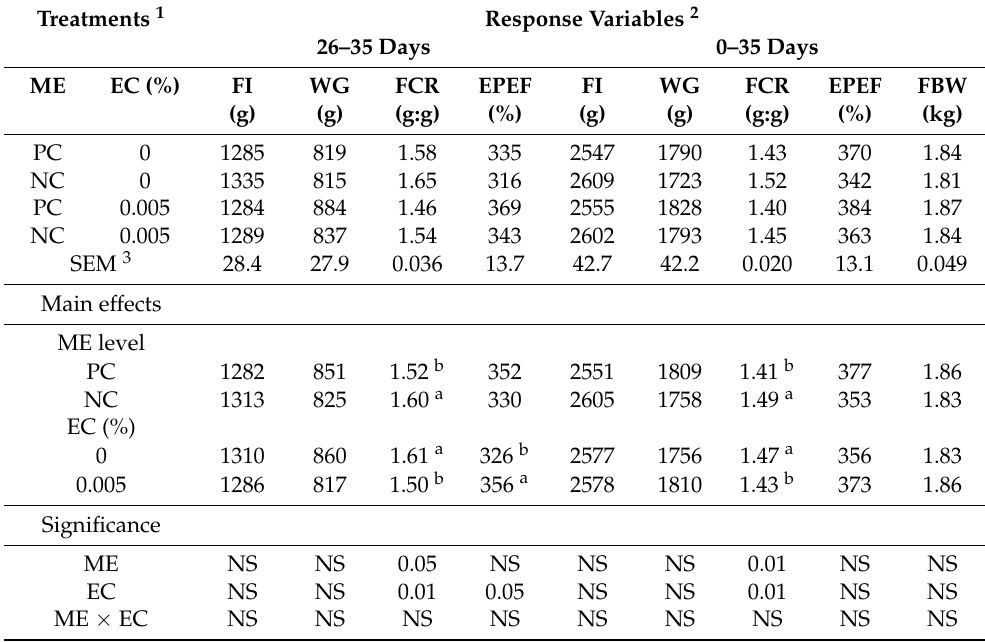
Table 3. Effect of dietary metabolizable energy (ME) level, enzyme cocktail (EC) supplementation, and their interaction on broiler performance in the finisher (26–35 days) and overall (0–35 days)